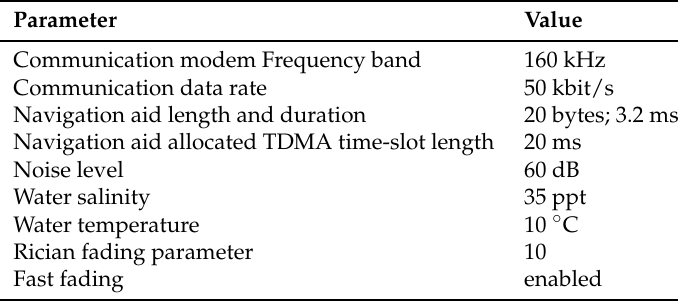
Table 3. Intra-swarm communication modem and channel